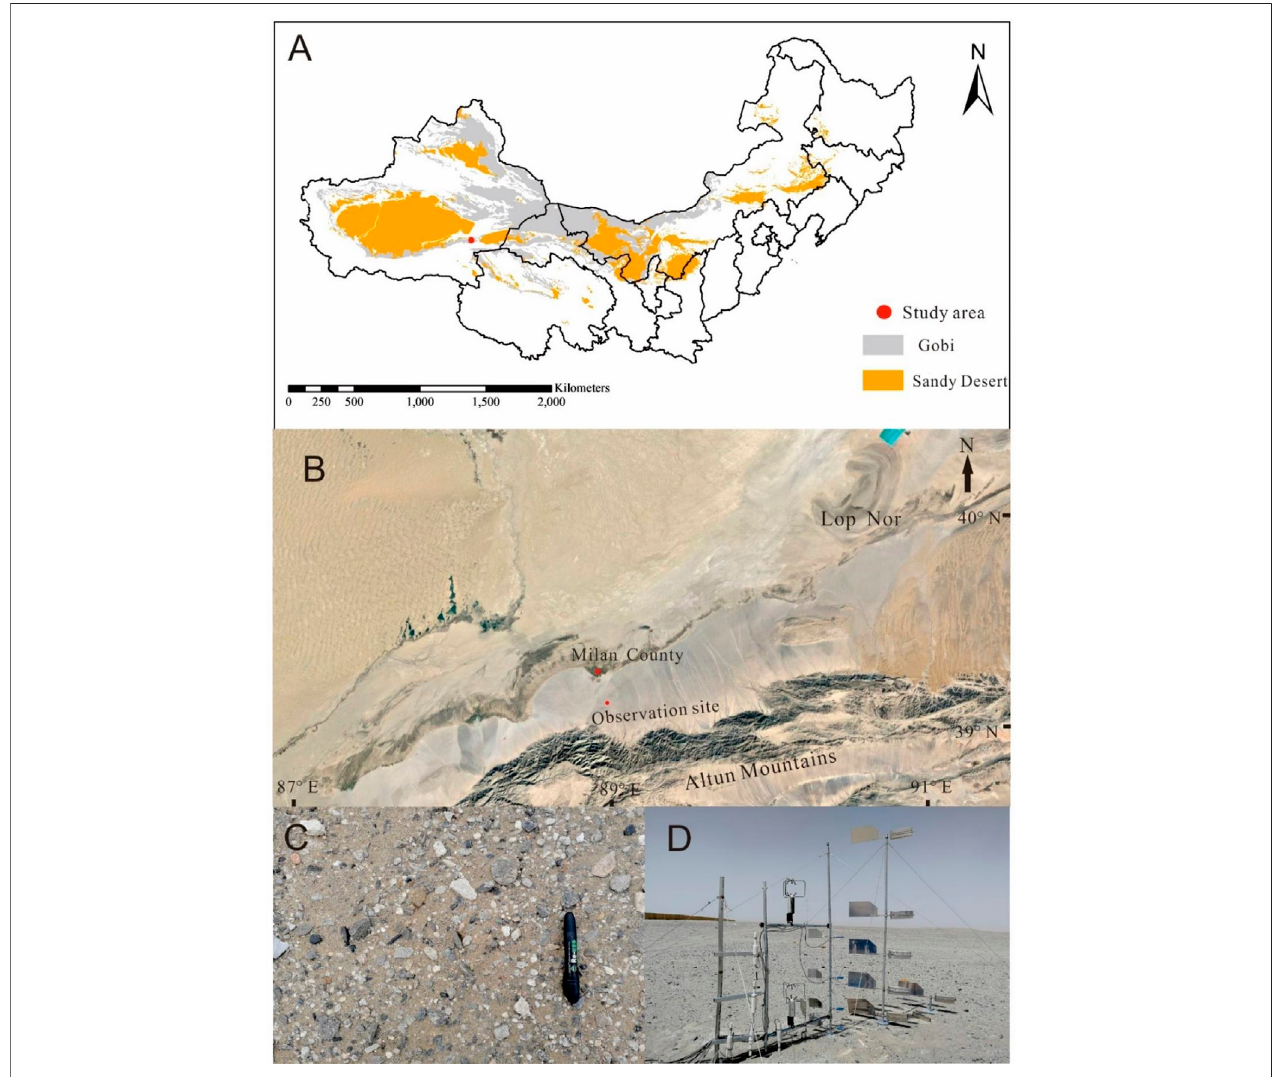
FIGURE1|(A) Thegobidistribution mapofNorthwest China[this fi gureisrevisedfromZhangetal.(2019)]. (B) Locationmapforthestudysite(theregionalmapis from Google Earth). (C) Typical gobi surface in the study site. (D) In-situ fi eld layout of instrument.